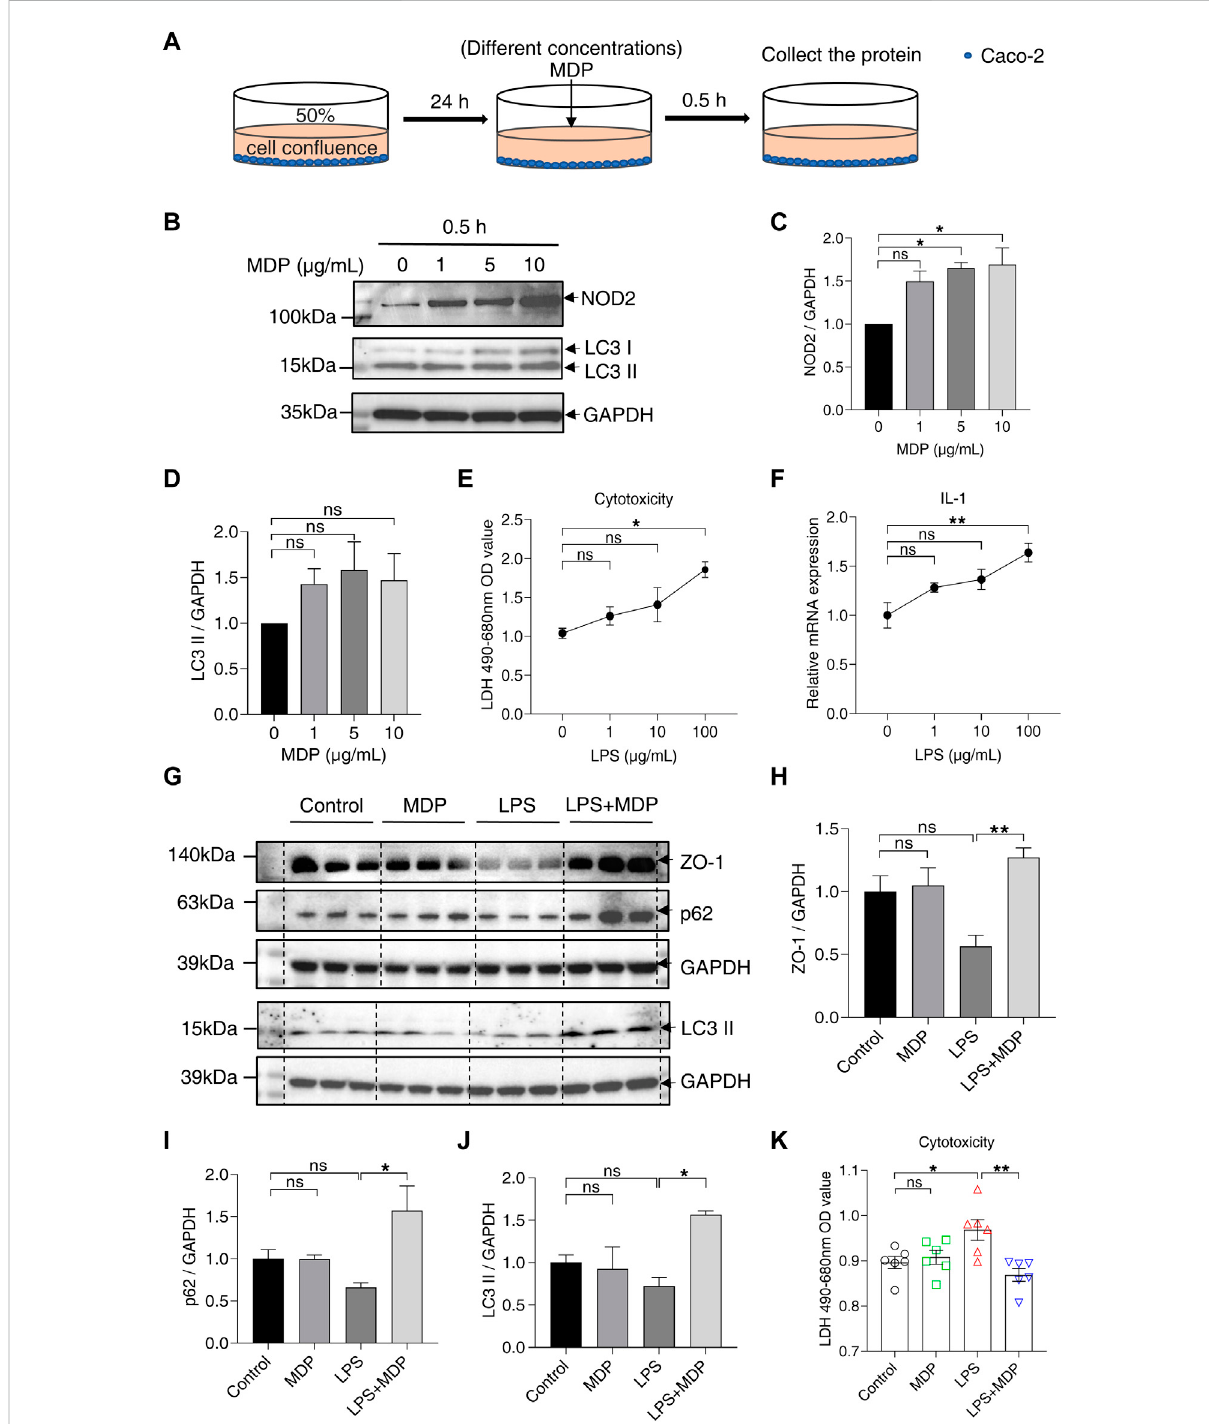
FIGURE 6 MDP reduces intestinal barrier damage and activates autophagy in vitro . (A) Schematic diagram of the administration of MDP (0, 1, 5, 10 μ g/ml, respectively) in Caco-2 cells. (B) Western blotting analysis for NOD2, LC3 I, and LC3 II with GAPDH as the internal standard protein in Caco-2 cells. Representativeimagesoftheimmuneblottingwereshown. (C,D) Quanti fi cationoftherelativeexpressionofNOD2andLC3IIinpanel(B)byImageJ, respectively. Results were from three independent experiments. (E) Cytotoxicity of Caco-2 cells with the administration of with LPS (0, 1, 10, 100 μ g/mL,respectively)for24hbytestingLDHODvalue. (F) RelativeRNAlevelsofIL-1 β ofCaco-2 cellswiththeadministration ofLPS. (G) Western blotting analysis for ZO-1, p62, and LC3 II with GAPDH as the internal standard protein in Caco-2 cells of the groups (Control, MDP, LPS, and LPS + MDP), respectively. Representative images of three duplicate samples of the immune blotting were shown. (H – J) Quanti fi cation of the relative expression ofZO-1, p62,and LC3 II in panel (G) byImageJ, respectively. (K) Cytotoxicity of Caco-2 cells of thegroups (Control, MDP, LPS, and LPS + MDP) by testing LDH OD value. Data were expressed as mean ± SEM. * p < 0.05, ** p < 0.01, ns, not signi fi cant, One-way